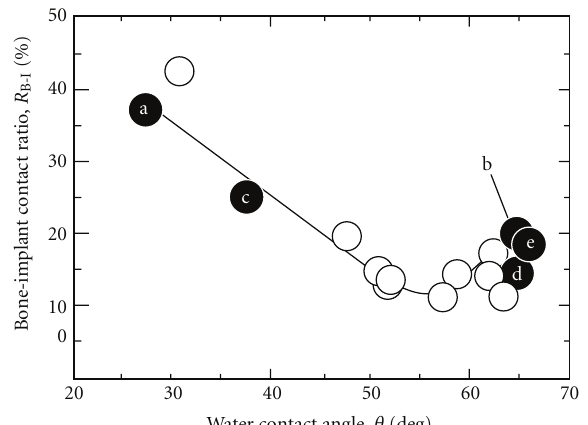
Figure 5: Relationship between the WCA and R B-I values in the cortical bone part. The symbols in closed circle correspond to the letters in Figure 4. Open circles represent the data for the sample anodized in various aqueous solutions, taken from previous work